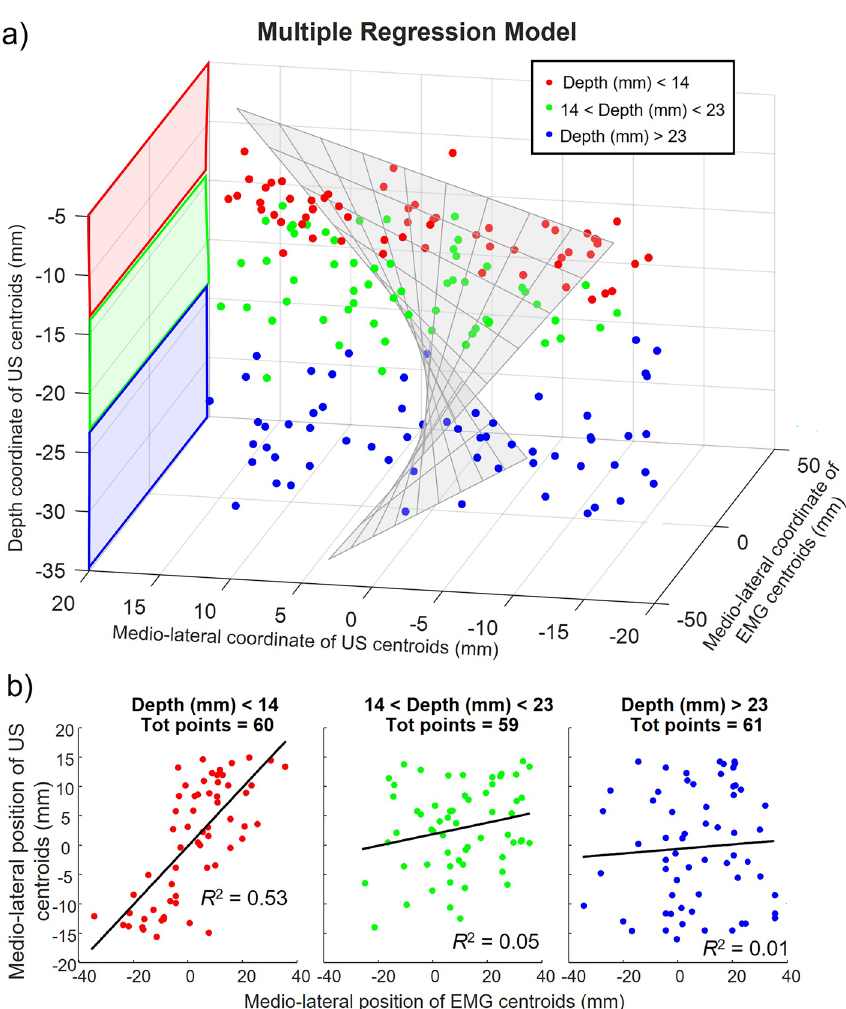
Figure 5. Group results of the experimental data. ( a ) 3D scatterplot of the relationship between the medio- lateral coordinates of centroids in EMG and US identified area, considering the effect of the depth in US. The surface represents the best fit of the multiple regression model. ( b ) Scatterplots of the MU divided by the US identification depth. From left to right: depth < 14 mm (N = 60), depth > 14 mm and < 23 mm (N = 59), depth > 23 mm (N =